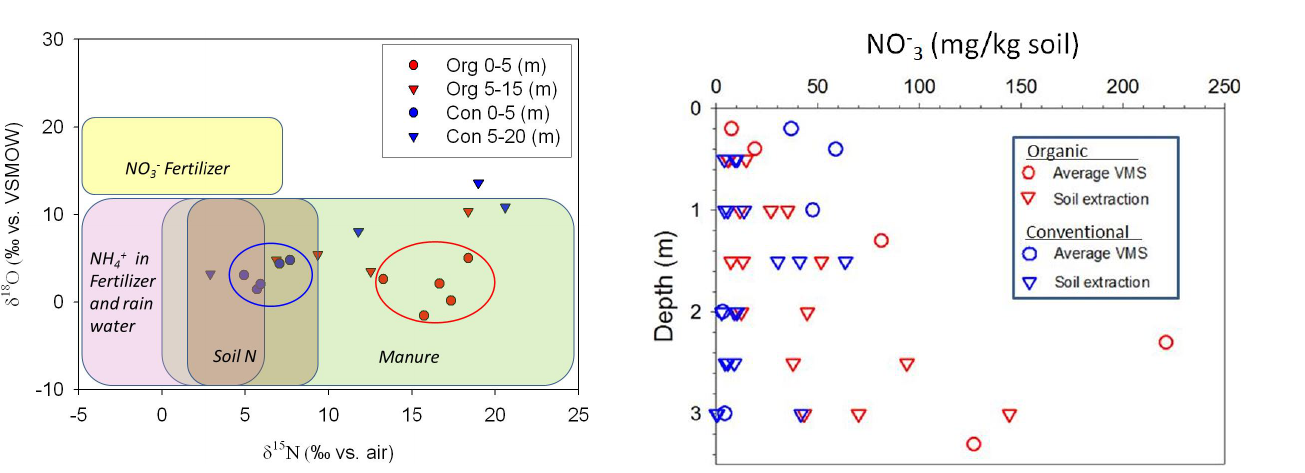
Fig. 6. Nitrate concentrations in sediment samples (soil extraction) and pore water (average VMS) in the vadose zone underlying or- ganic and conventional